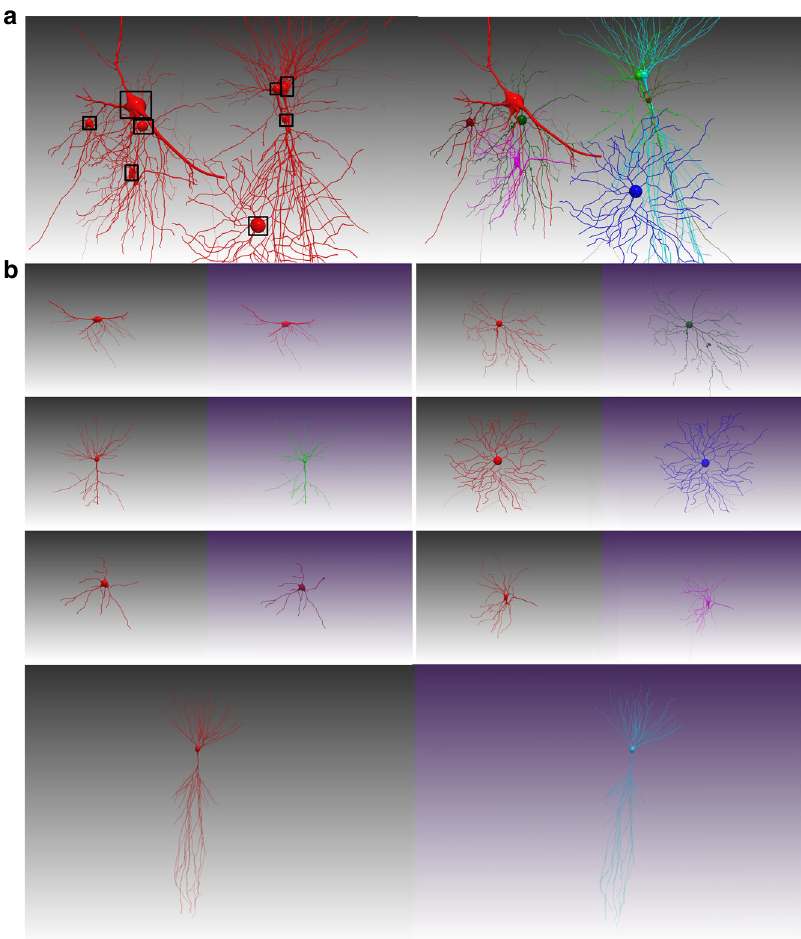
Fig. 4 Segmentation accuracy of G-Cut on a simulated neuron cluster. a A simulated neuron cluster (left panel) and segmentation result (right panel). Each segmented neuron is given a unique color for easier visualization. b Comparison between each original neuron (left) and segmented neuron (right). The neurons are rotated for more effective visual presentation. Rendering is done with neuTube software